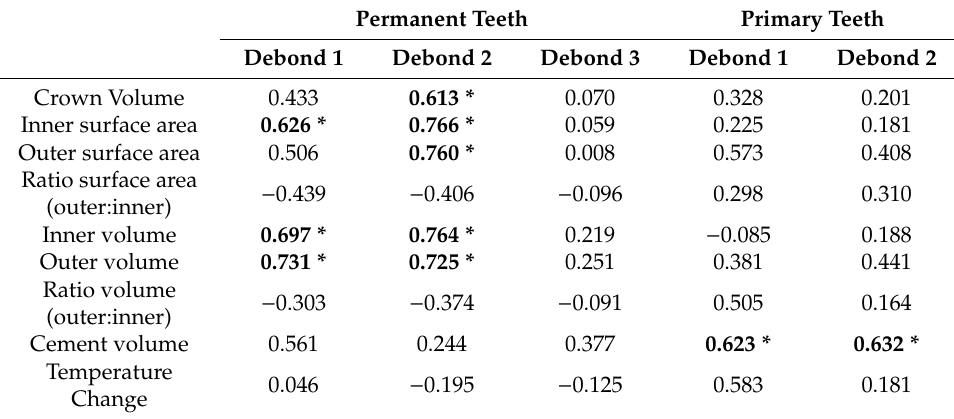
Table 2. Pairwise correlations between crown metrics and time to debond.